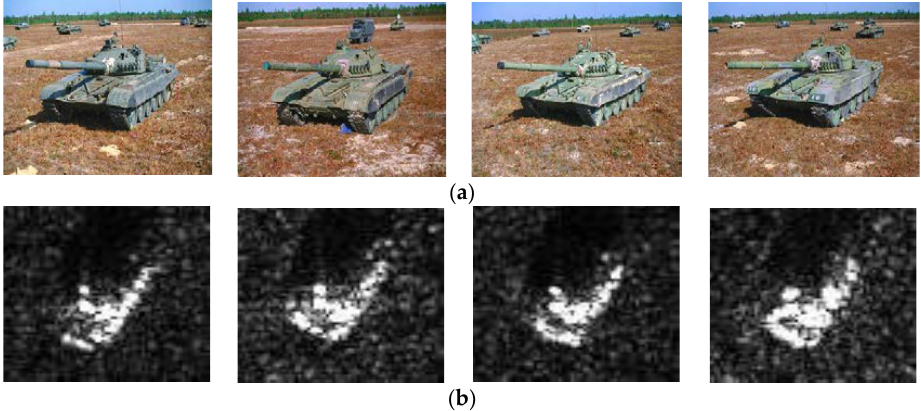
Table 7. PCCs of different methods under configuration variance.